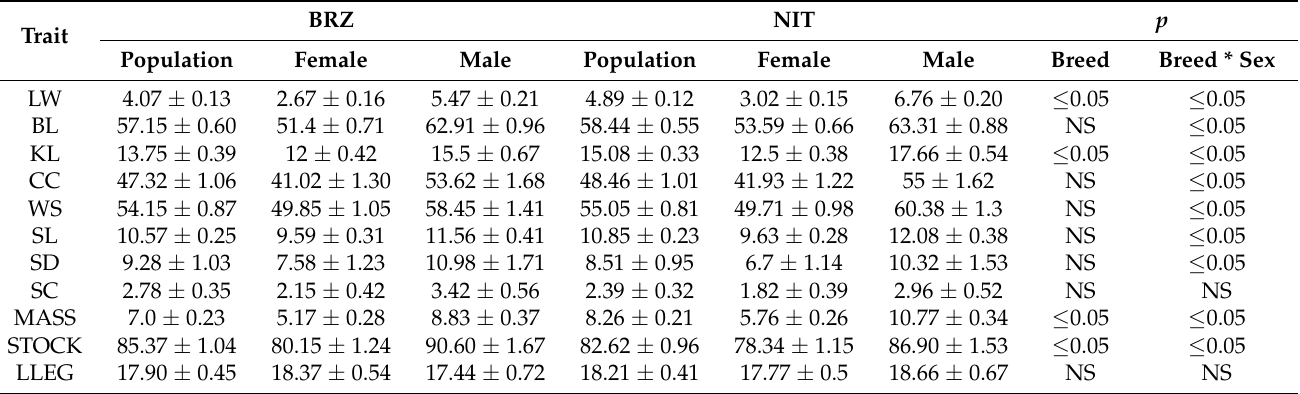
BRZ = Brianzolo breed, NIT = Nero d’Italia breed. MASS was higher in NIT turkeys (8.26 vs. 7.0; p ≤ 0.05), STOCK was higher in BRZ birds (82.62 vs. 85.37; p ≤ 0.05), whereas no significant differences were recorded in